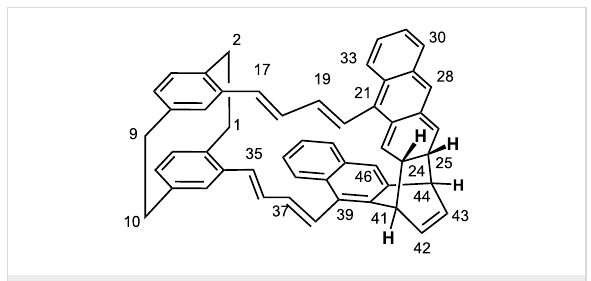
Figure 11: Proposed structure of 4 (1,4 : 2′,3′-cycloadduct).